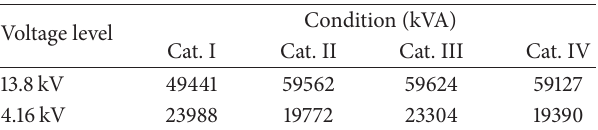
Table 4: Apparent power rating (kVA) loading summary of APR1400.